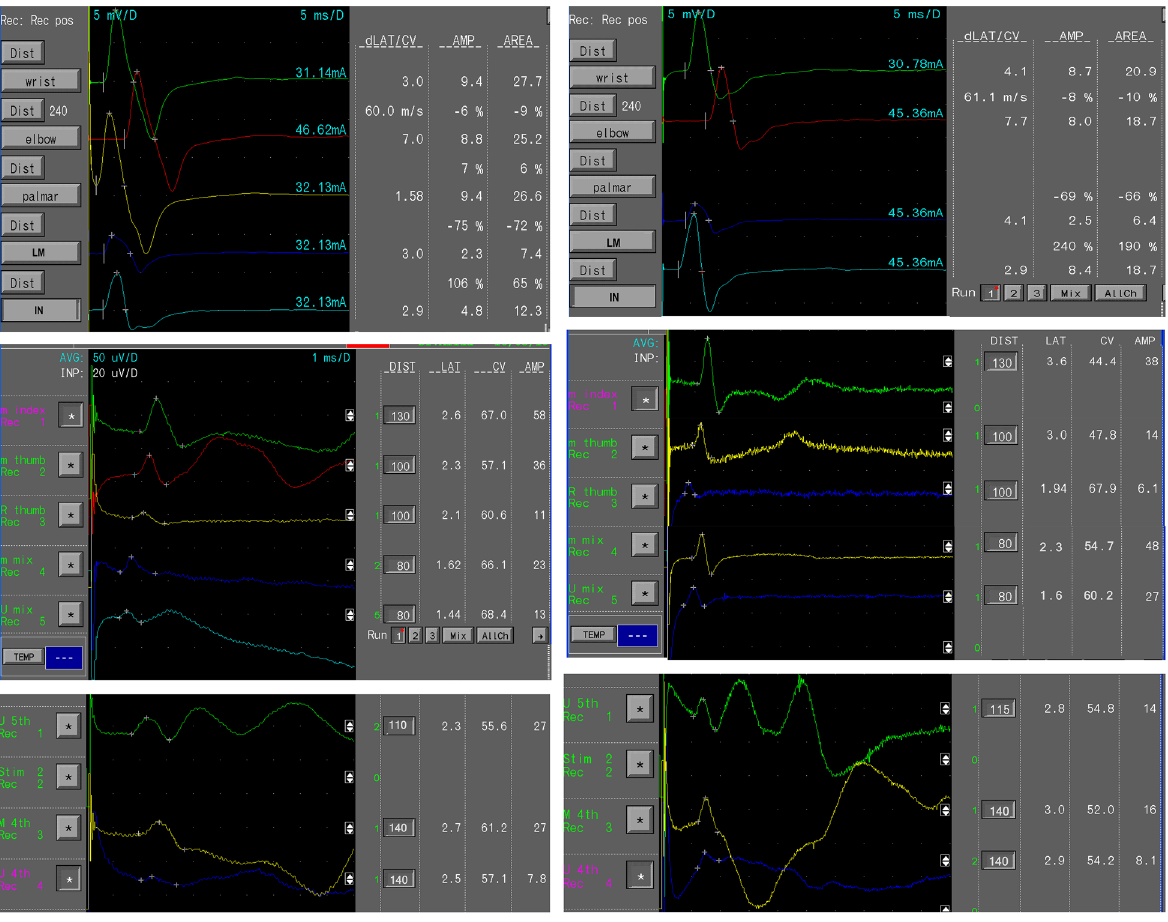
Fig. 2 Median versus ulnar mixed orthodromic sensory study technique. a MN recording electrodes at the wrist with G1 placed over the middle of the wrist between FCR and PL tendons and G2 placed 3–4 cm proximally. Stimulating electrode in the palm: 8 cm from the G1 on a line drawn from the median wrist to the web space between the index and middle fingers. b UN recording electrodes at the wrist with G1 placed over the medial wrist, adjacent to the FCU tendon, and G2 placed 3–4cm proximally. Stimulating electrode in the palm: 8cm from the active recording electrode on a line drawn from the ulnar wrist space between the ring and little